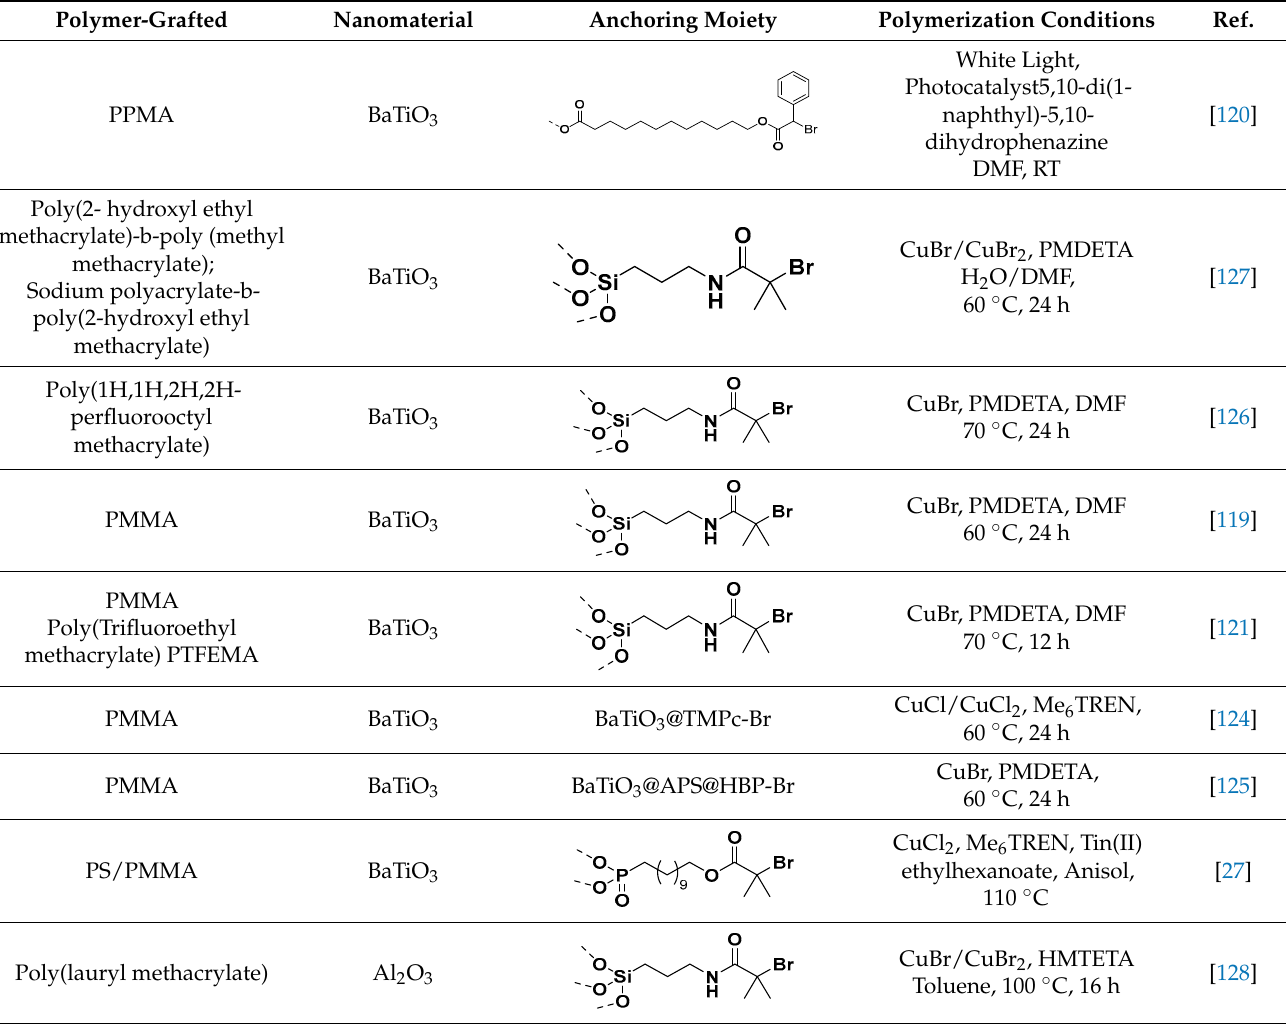
Table 4. Details about various polymer-grafted nanoparticles using ATRP. Polymer-Grafted